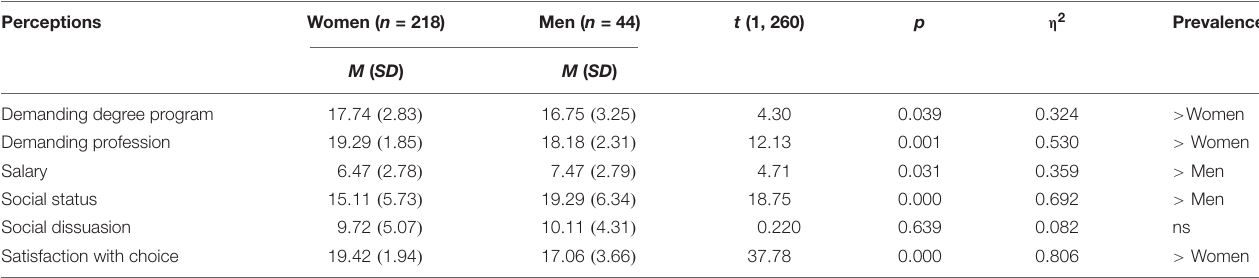
TABLE 5 | Means, standard deviations, analysis of variance, and effect size ( η 2 ) of the perceptions according to gender.